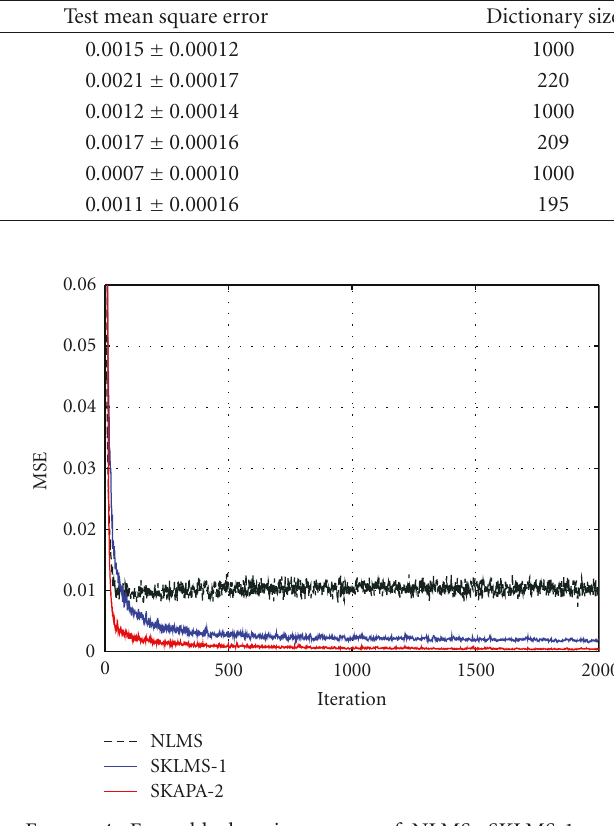
Figure 4: Ensemble learning curves of NLMS, SKLMS-1, and SKAPA-2 ( K = 10) in noise cancellation. Table 7: Noise reduction comparison in noise